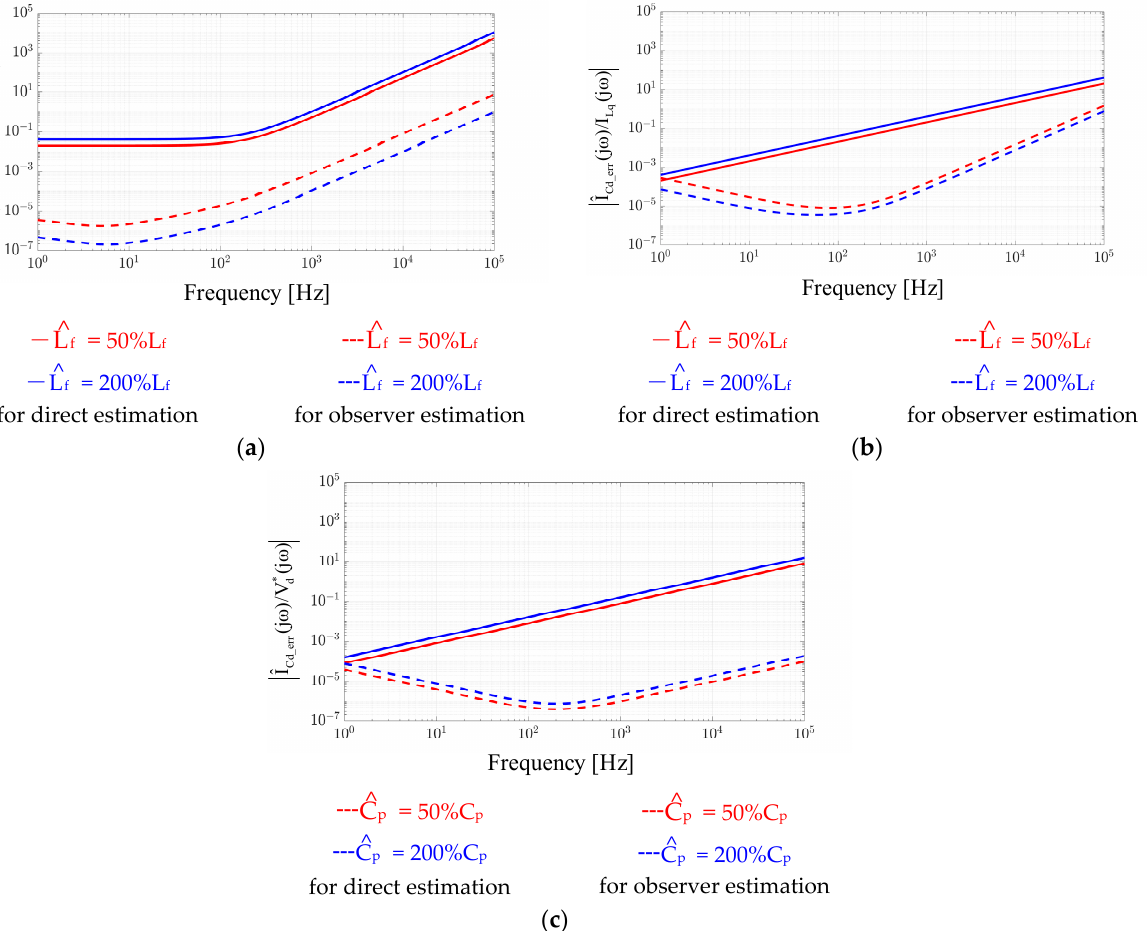
I^ Figure 5. Estimation accuracy evaluation of ˆI Cdq between direct estimation in Equation (13) and proposed ob- Figure 5. Estimation accuracy evaluation of Cdq between direct estimation in Equation (13) and proposed observer in server in Figure 6: ( a ) ˆL f error on |I Cd_err (j ω )/I Ld (j ω )|, ( b ) ˆL f error on |I Cd_err (j ω )/I Lq (j ω )|, and ( c ) ˆC p error on ^ L^ C^ * Figure 6: ( a ) L (j ω )|. f error on |I Cd_err (j ω )/I Ld (j ω )|, ( b ) f error on |I Cd_ err (j ω )/I Lq (j ω )|, and ( c ) p error on |I Cd_err (j ω )/V d |I Cd_err (j ω )/V ∗ (j ω d L^ Figure 5 illustrates the f error regarding the d-axis capacitor current estimation error I Cdq_err resulting from the self-coupled d-axis inductor current I Ld and cross- coupled q-axis current I Lq , respectively. As seen from |I Cd_err (j ω )/I Ld (j ω )| in (a), a constant error occurs at low frequency. In contrast, for |I Cd_err (j ω )/I Lq (j ω )| in (b), the estimation error increases as frequency increases. Besides, Figure 5c shows the C^ p error on I Cd_err caused by the self-coupled d-axis voltage command V d * . As seen from Equation (15), the estimation error also increases as frequency increases. A similar result can be found for the L^ f error on cross-coupled |I Cd_err (j ω )/I Lq (j ω )|. Based on the sensitivity analysis on the direct I ^ Cdq estimation in Equation (13), the L ^ f error results in a constant estimation error on I^ Cdq at low frequency, and more importantly, the estimation error increases as the operating frequency increases. Below, a closed-loop observer-based current estimation is proposed to reduce this parameter sensitivity. Similar to the capacitor voltage observer, the capacitor current I Cdq can be estimated through another closed-loop observer to improve the estimation performance. Figure 6 proposes another current observer for both I Cdq and machine current I dq estimation. In this observer, the input is the estimated capacitor voltage V^ Cdq from the first observer in Figure 4, and the outputs are the estimated capacitor current I^ Cdq and machine current